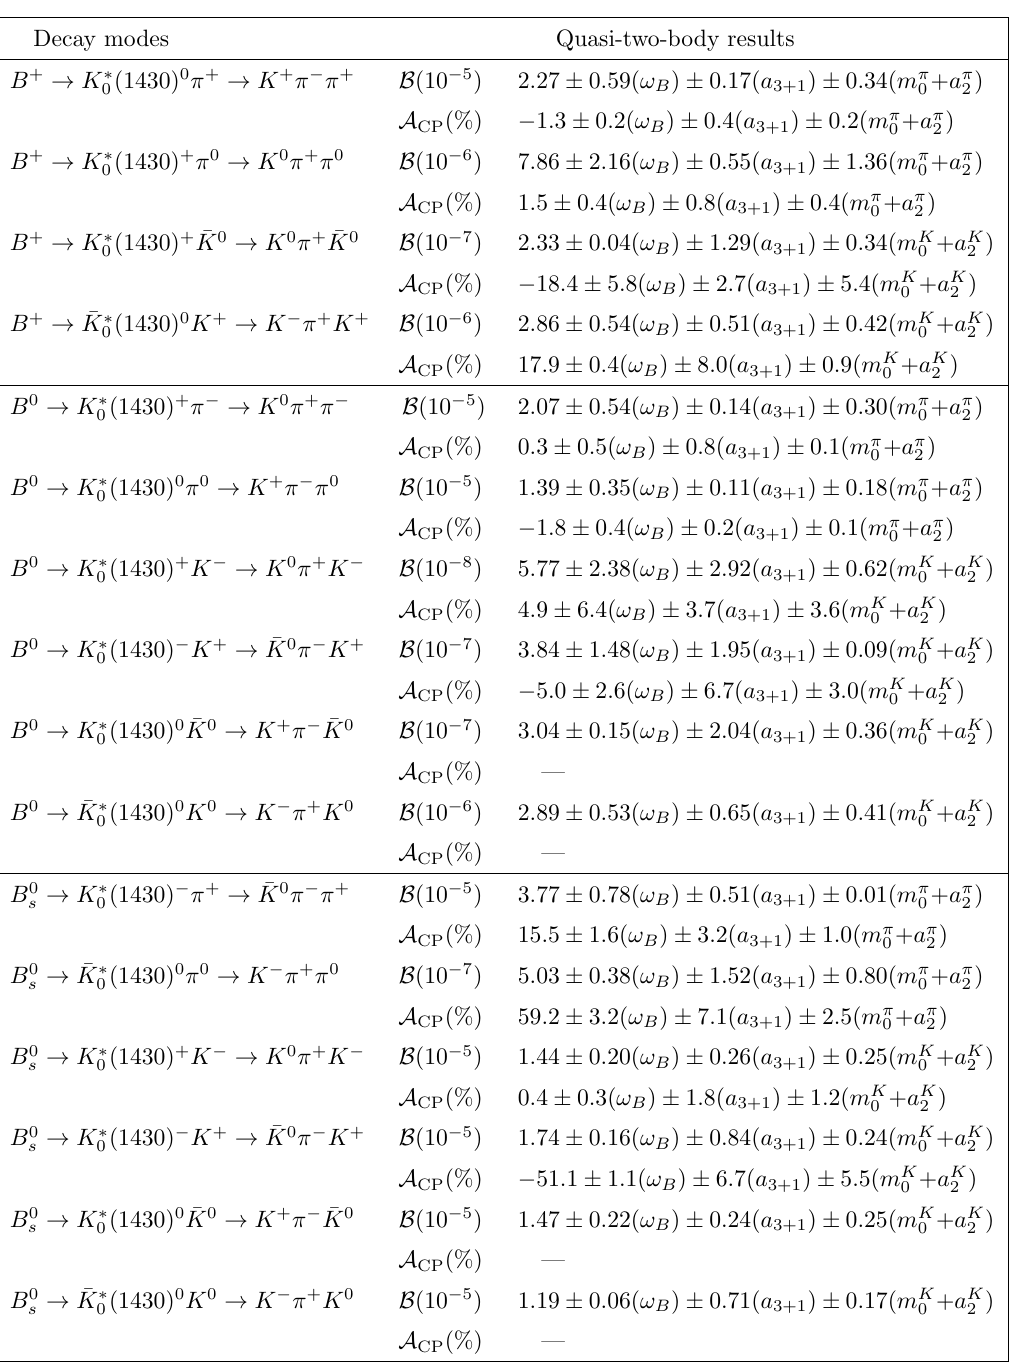
Table 2 . PQCD predictions of the CP averaged branching fractions and the direct CP asymmetries for the quasi-two-body B ! K (cid:3) (1430) h ! K(cid:25)h decays. 0